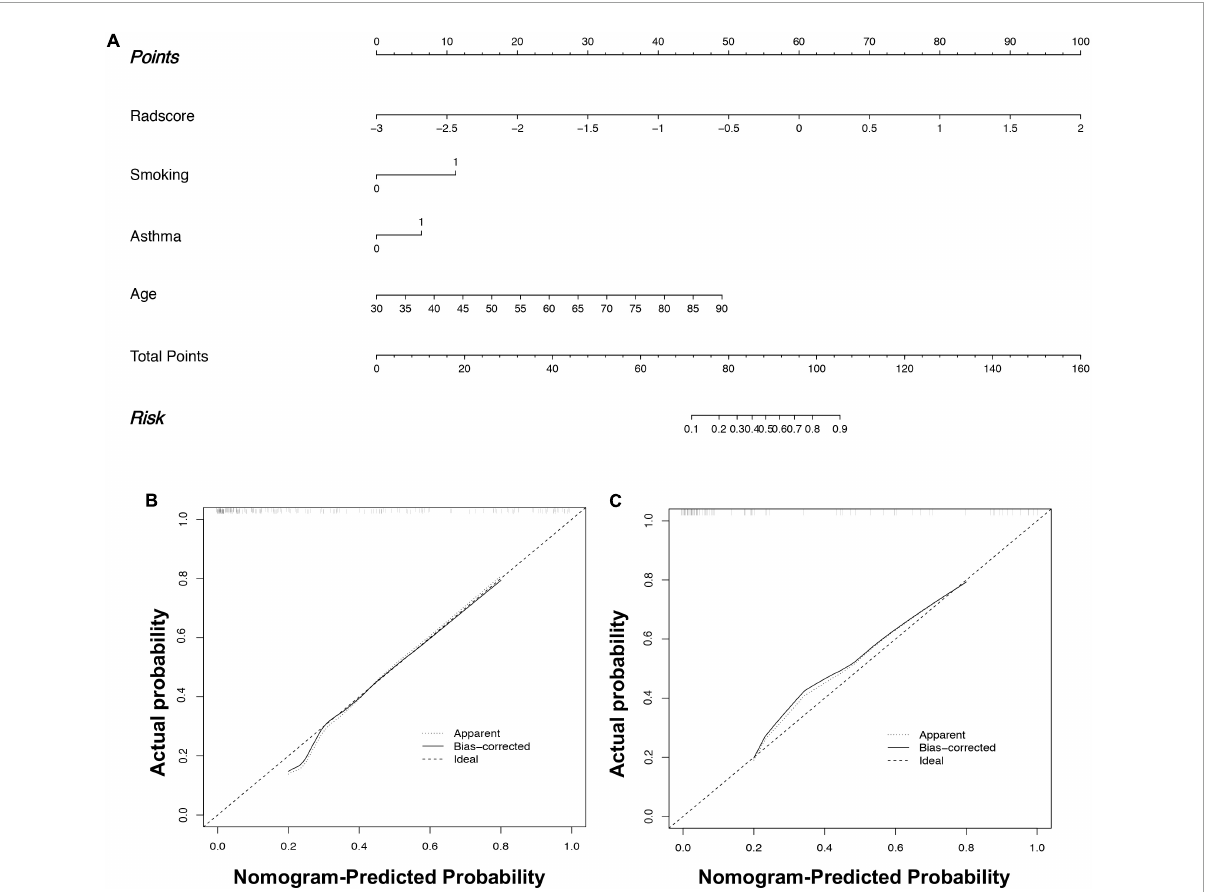
FIGURE5 Radiomics nomogram (A) to predict fSAD. Using the training cohort data, the rad-score, age, smoking history, and asthma history were used to construct the radiomic nomogram. fSAD Calibration in (B) the training cohort and (C) the external validation cohort. The dashed reference line indicates the optimal nomogram. A dotted line represents the performance of the radiomic nomogram to predict high risk, and the solid line shows the correction of the nomogram’s deviation. fSAD, small airway